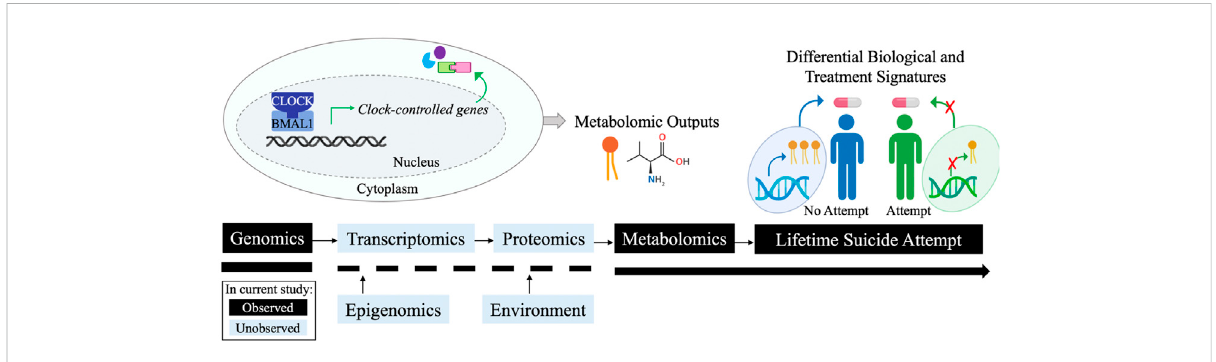
FIGURE 4 Conceptualsummary.Simpli fi edcircadianrhythmloop.Tuningofsuchloopsoccursbymultiplemechanisms(blueboxes).Blackboxesdenote available data and blue boxes denote unavailable data in the current analysis. Figure created with